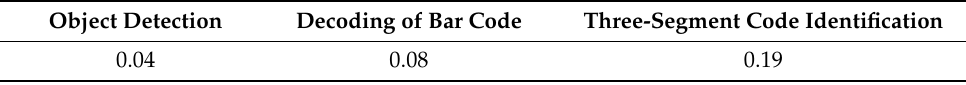
Table 9. Method time